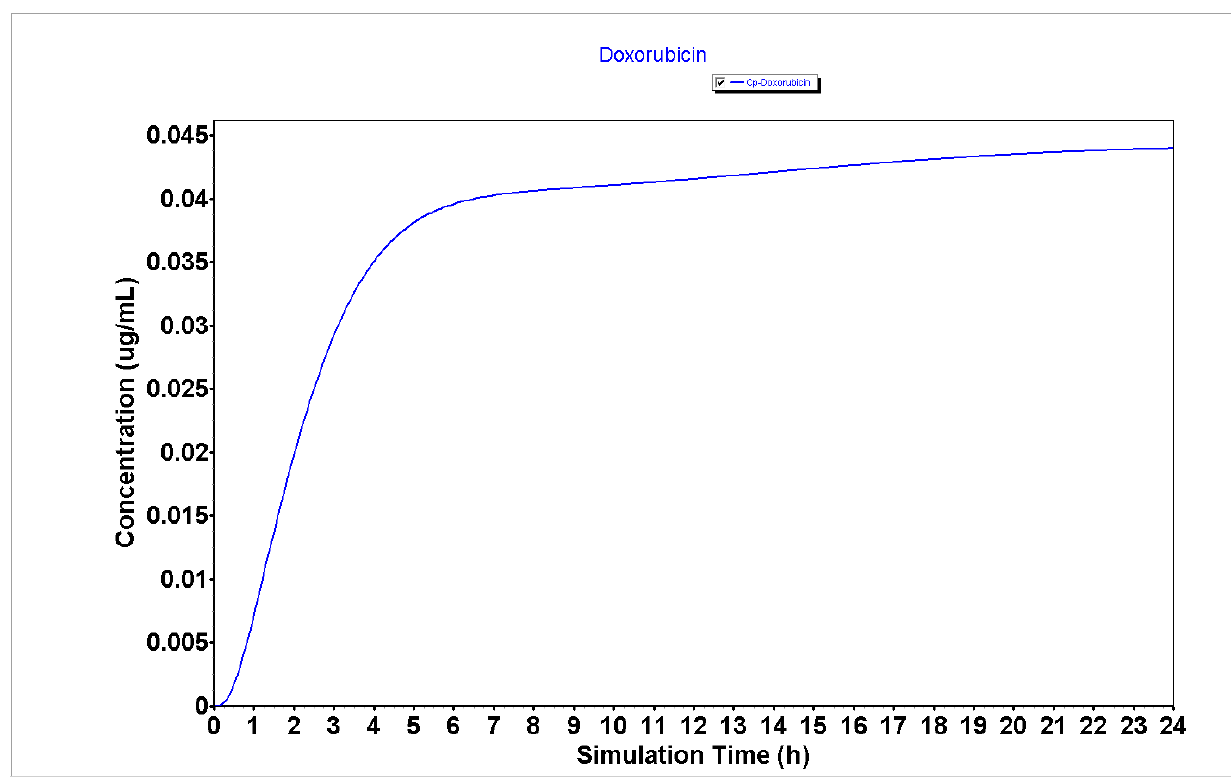
Figure 1. Plasma concentration of 5-FU generated using the GastroPlus ® software.